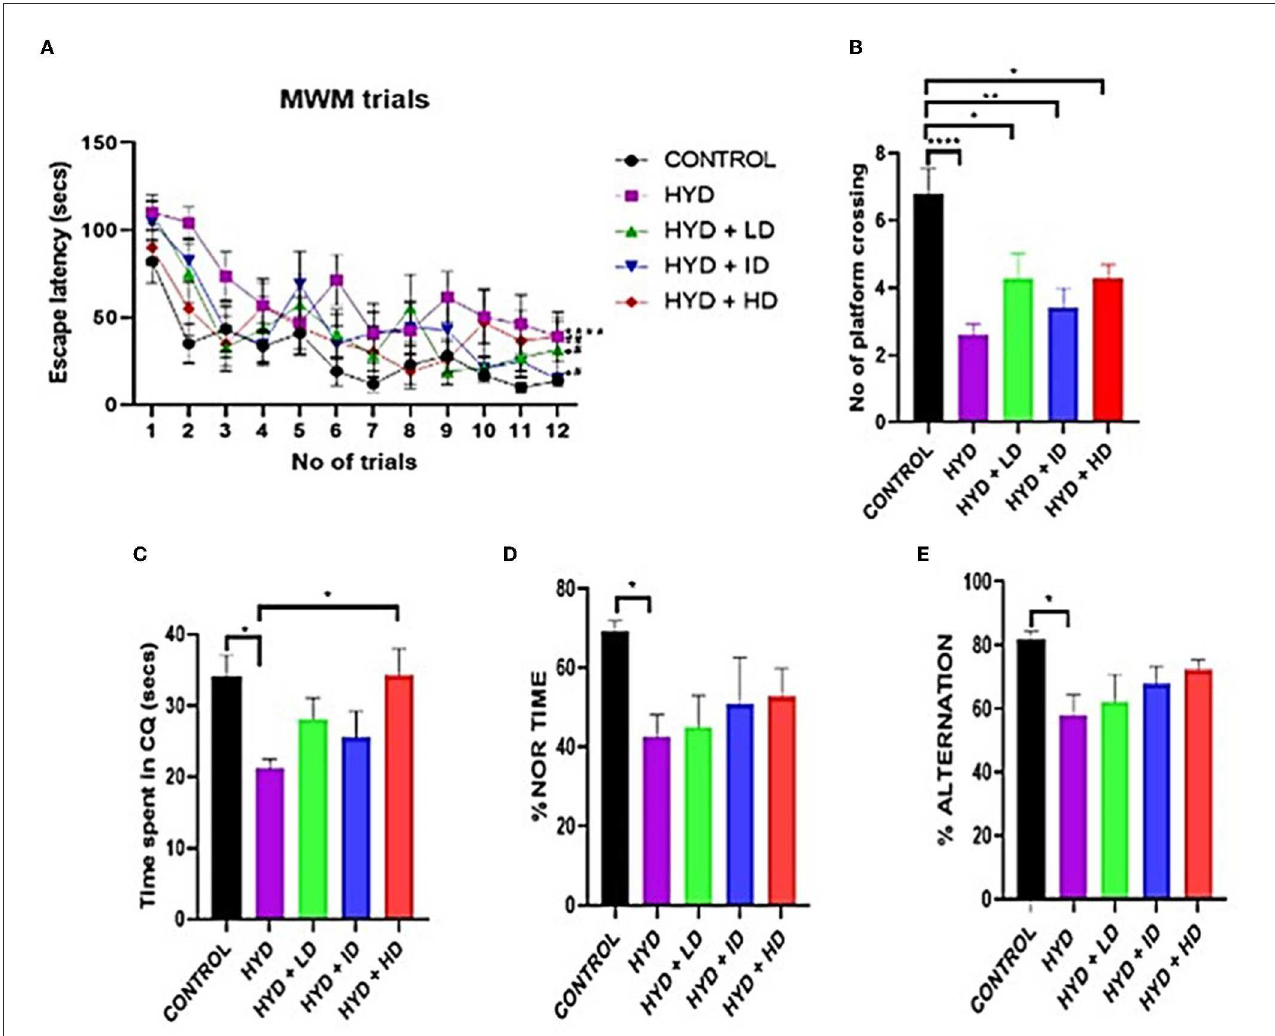
FIGURE3 Behavioral tests. (A) Line graph showing the escape latency period of control and experimental animals. (B–E) Bar charts showing the number of platform crossing; time spent in the correct quadrant; % novel object recognition time and % alternation of control and experimental mice. (Control n = 10; HYD n = 10; HYD + LD n = 7; HYD + ID n = 7; HYD + HD n = 7. *compared to control; # compared to hydrocephalic